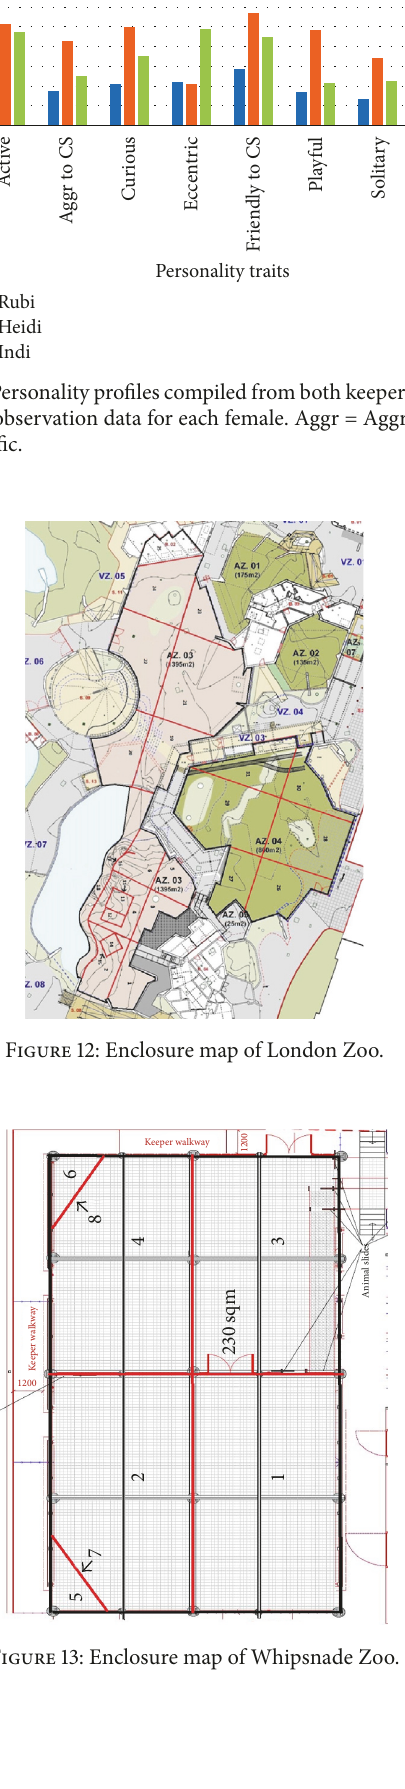
Table 5: Weekly enclosure use values for London Zoo daytime observationstodemonstratehowthefemales’enclosureusechanged